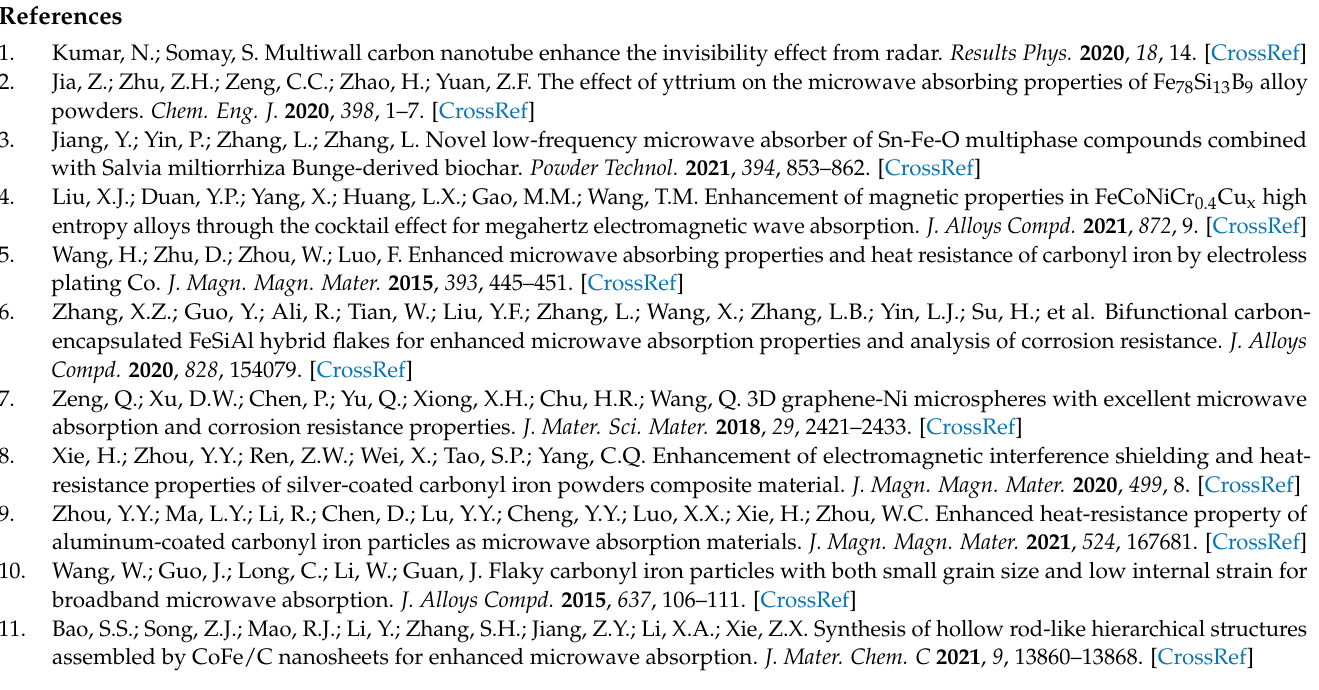
powders; Figure S1: Morphology and particle width change of FeCoCr powders at different milling times; Figure S2: High-resolution TEM image and SAED pattern of raw and milled for 4 h FeCoCr powder; Figure S3: Changes of XRD spectra of the FeCoCr powders during ball milling and heat treatment; Figure S4: Evolution of saturation magnetization ( M s ) and coercivity ( H c ) during ball milling and subsequent heat treatment; Figure S5: Change of M s with the increase in temperature for FeCoCr powders after milling for 4 h and heat treatment at 500 ◦ C; Figure S6: Change of magnetic loss tangents (tan δ µ ) in FeCoCr powders during ball